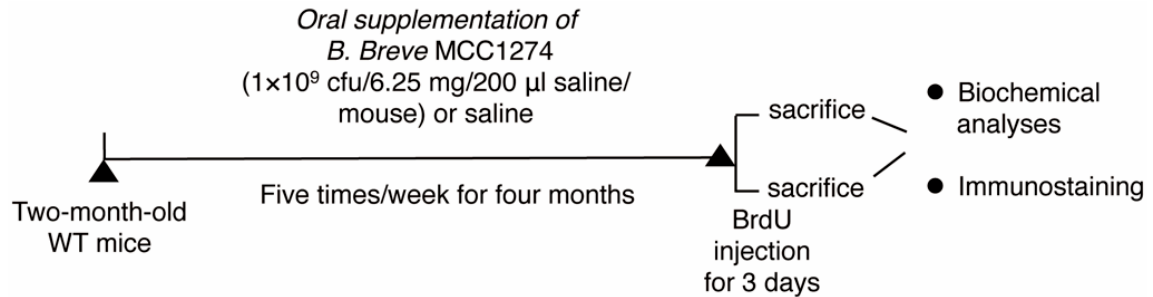
Figure 1. A schematic figure explaining the timeline of the experiment. Two-month-old wild-type (WT) mice were randomly divided into saline and probiotic groups: the saline group received saline, and the probiotic group ( n = 20 per group) was supplemented with B. breve MCC12741 (1 × 10 9 cfu/6.25 mg/200 µ L saline/mouse) via oral gavage five times/week for 4 months. At the end of supplementation, mice were injected with BrdU and were then sacrificed, and their brains were collected for immunostaining and biochemical analyses.